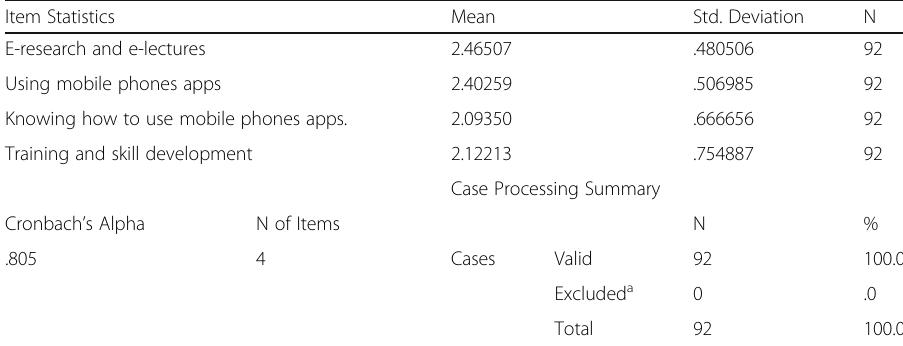
Table 2 Statistic answers on the closed